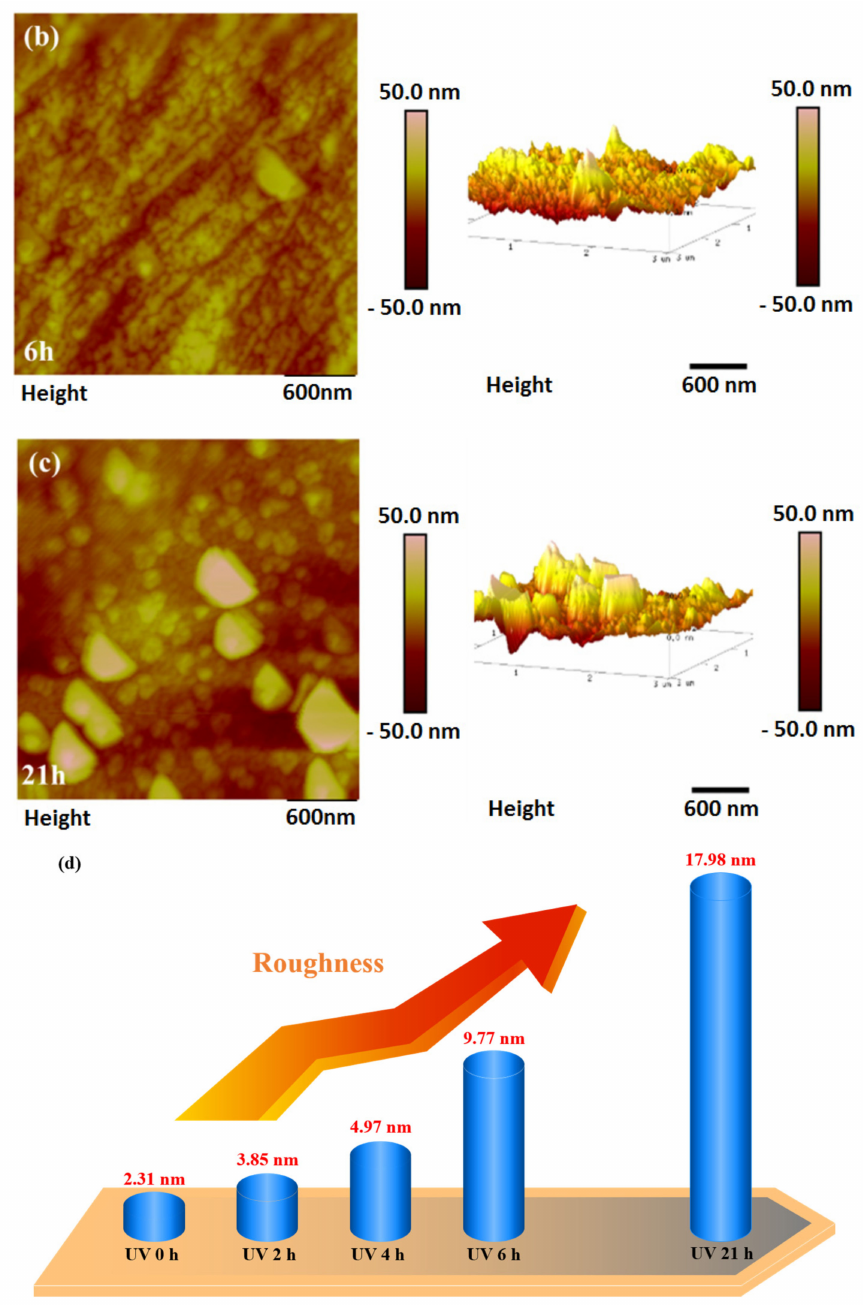
Figure 3. The surface morphology and roughness of PI films with different UV irradiation times. ( a ) irradiated for 0 h; ( b ) irradiated for 6 h; ( c ) irradiated for 21 h; ( d ) the roughness of PI films at different UV irradiation